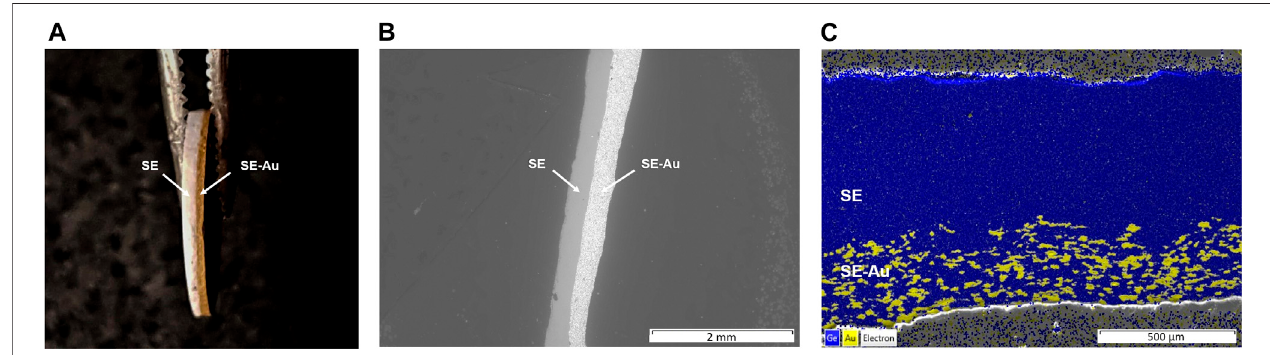
FIGURE2|(A) PictureofaSE-Au/SEstackaftercompletingsintering,calcinationandpolishingprocesses, (B) SEMmicrographofanLAGP-Au/LAGPstackcross section ( × 30), gold particles appear in light gray, (C) SEM micrograph and corresponding EDS analysis map of an LAGP-Au/LAGP stack cross section ( × 120), Au is represented in yellow, Ge in